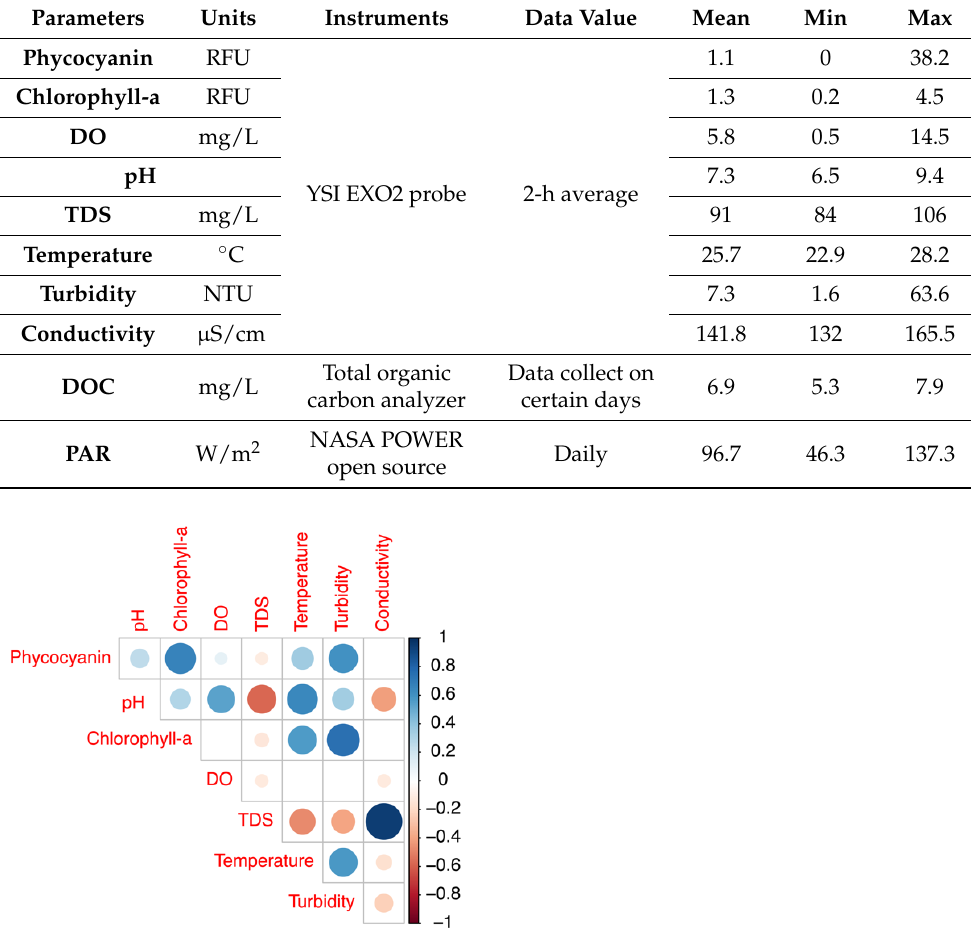
Table 1. Physicochemical variables for the raw water of Bedford DWTP during July and August of 2018.